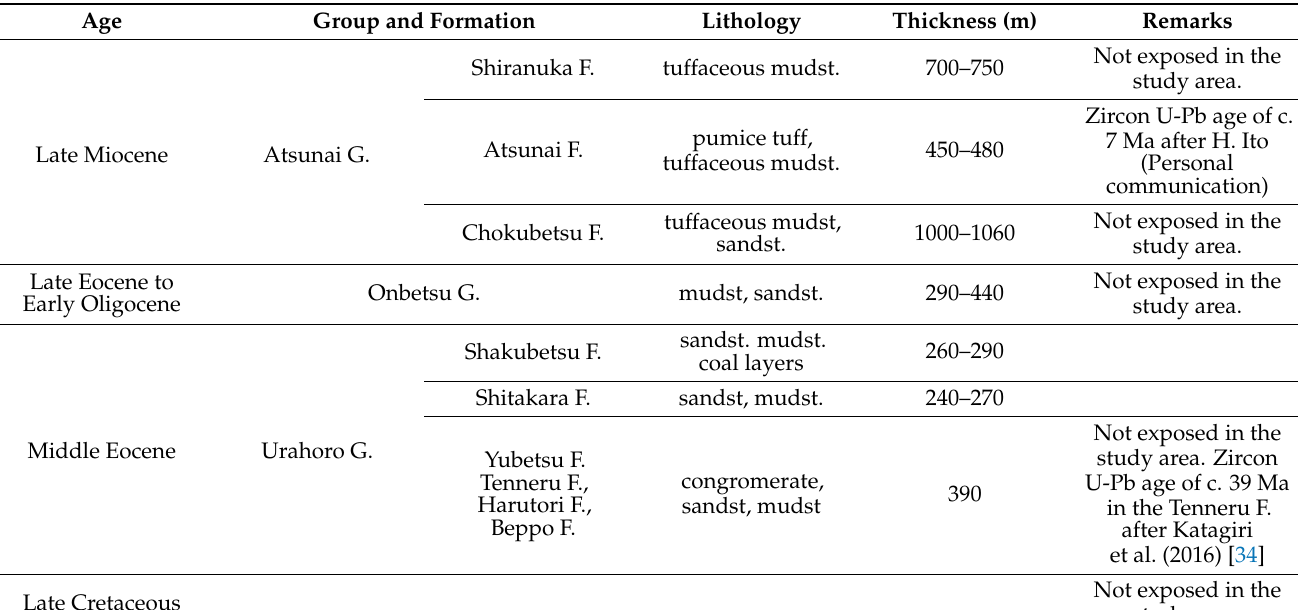
Table 1. Stratigraphy of the study area after